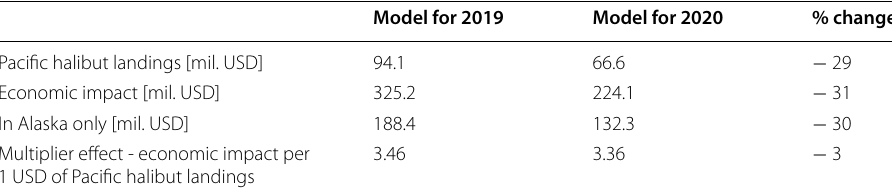
Table 2 Comparison of results derived from updated